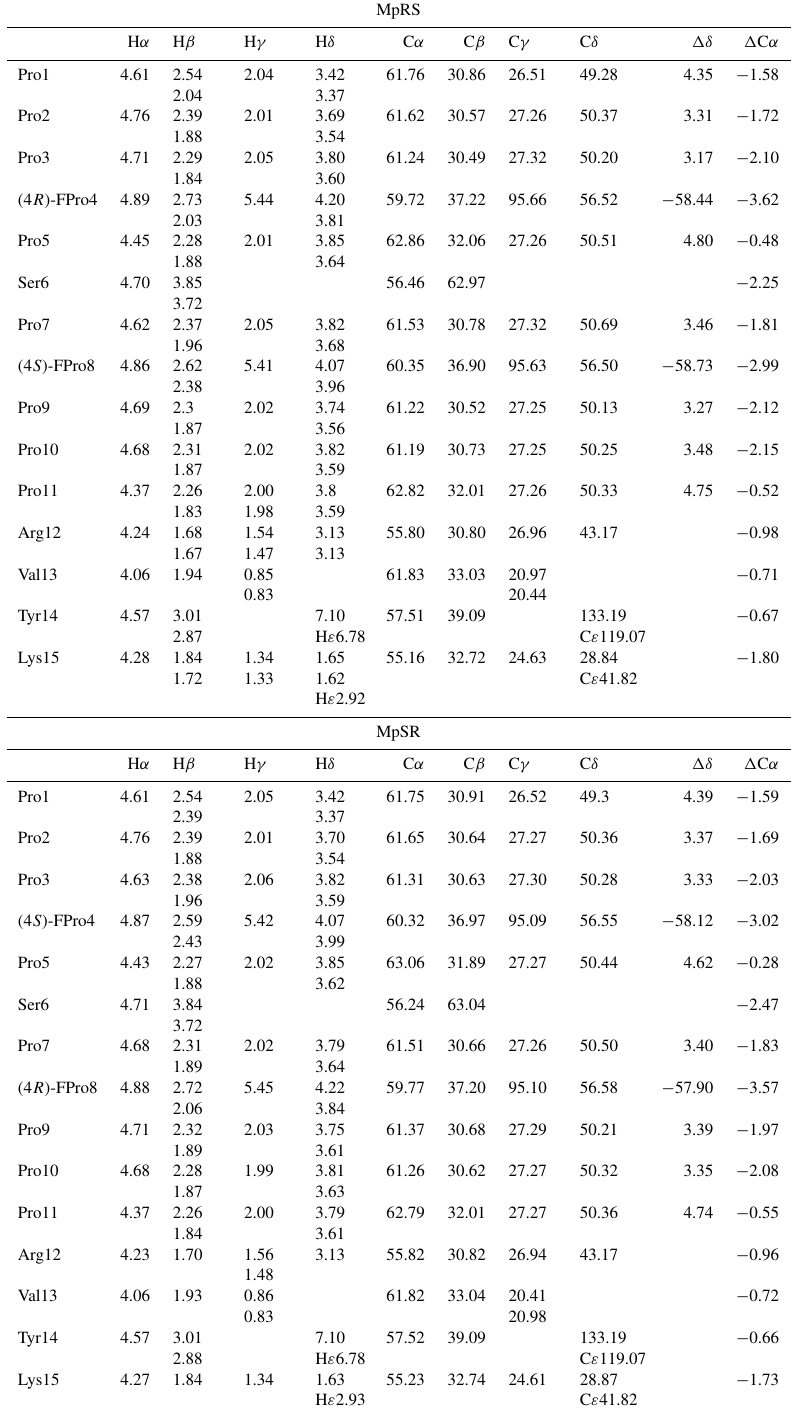
Table 1. Chemical shift assignments of MpRS and MpSR peptides. (cid:49)δ is the chemical shift difference between 13 C β and 13 C γ resonances used as indicator for cis and trans conformations of the Xaa–Pro peptide bond (where Xaa represents any amino acid). (cid:49) C α is the chemical shift difference between the measured 13 C α and the corresponding random coil values. Chemical shifts were measured in D 2 O (at pH 7, 298K) and referenced to DSS-d 6